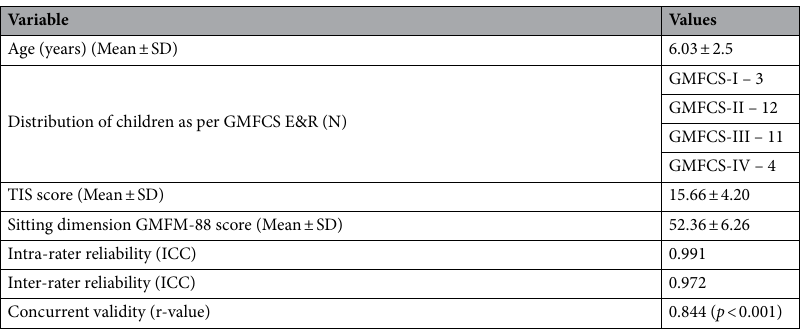
Table 1. Representing age of the subjects, GMFCS level, TIS values, sitting dimension GMFM-88 scores, validity, and reliability values of the TIS scale. SD: Standard Deviation, GMFCS E&R: Gross Motor Classification System Expanded & Revised, TIS: Trunk Impairment Scale. GMFM: Gross Motor Function Measure, ICC: Intraclass Correlation Coefficient, N: Number of subjects.